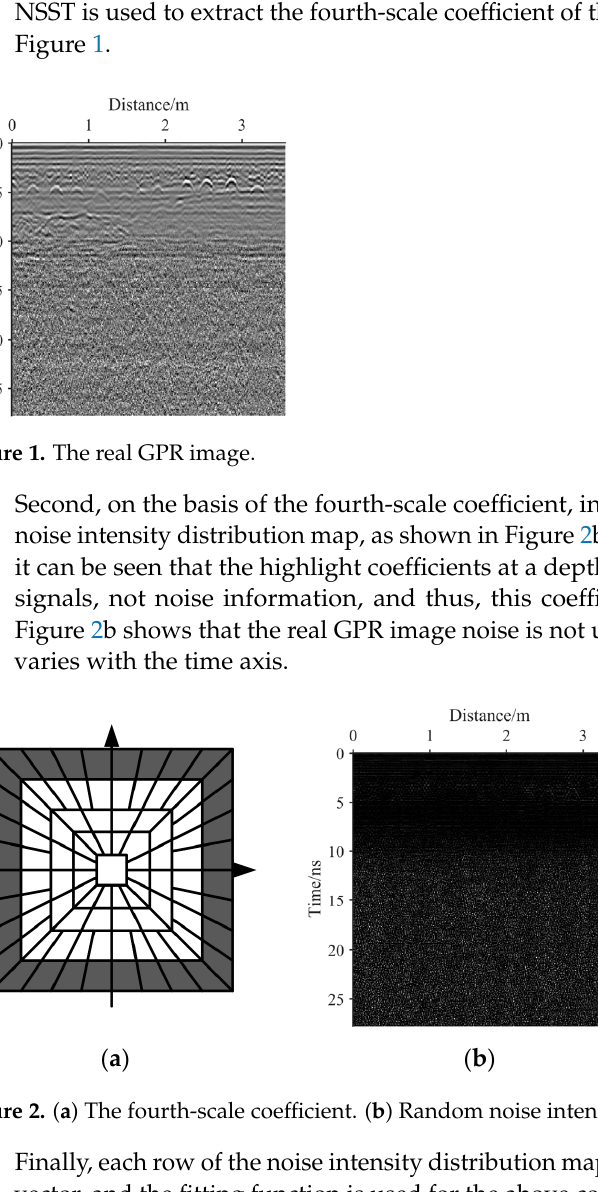
Figure 2. ( a ) The fourth-scale coefficient. ( b ) Random noise intensity distribution map. 3 Finally, each row of the noise intensity distribution map is summed to obtain a column vector, and the fitting function is used for the above column vector to obtain a relative noise intensity trend curve, as shown in Figure 3.